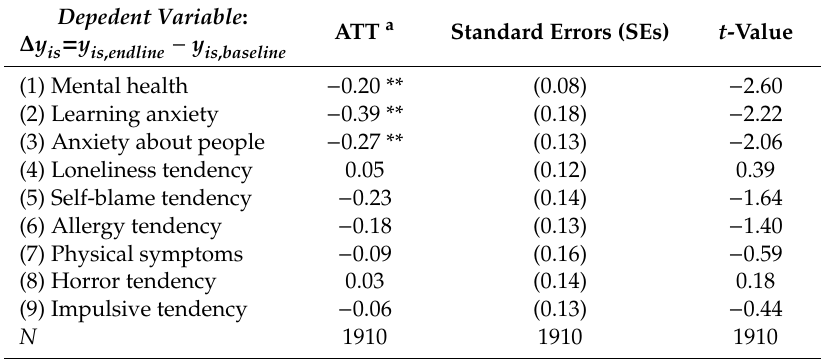
Table 7. The e ff ect of boarding on students’ mental health from heterogeneity of grade 4 and grade 5. Depedent Variable : ∆